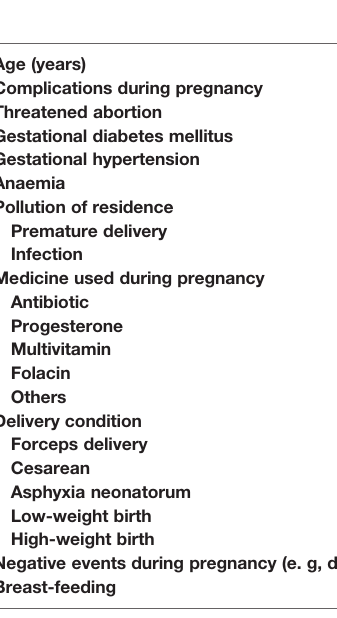
TABLE 3 | Comparisons of childbearing age, pregnancy, delivery and breastfeeding conditions between the two groups of mothers at the follow-up.